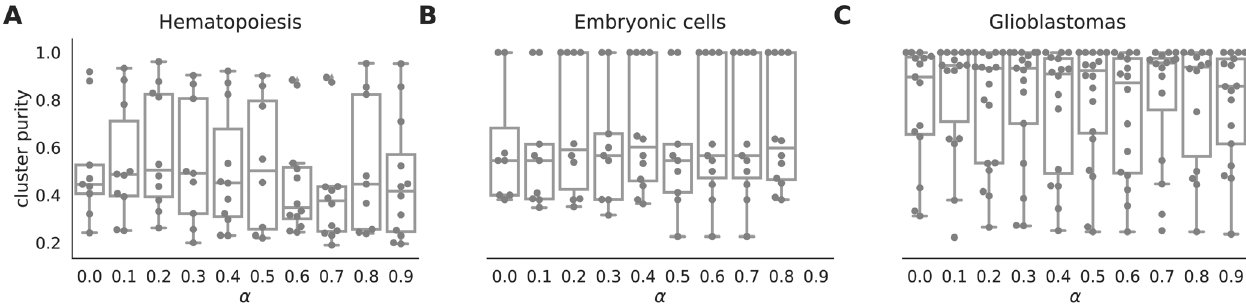
Figure 11. boxplots of cluster purity for clusters obtained by the robust clustering procedure following application of netSmooth with different values of α . α = 0 is equivalent to not using netSmooth at all. The procedure is robust to alpha, that is, most values of alpha produce more robust clusters. A ) HSPCs, B ) embryonic cells, C ) glioblastomas. The online version of this figure is